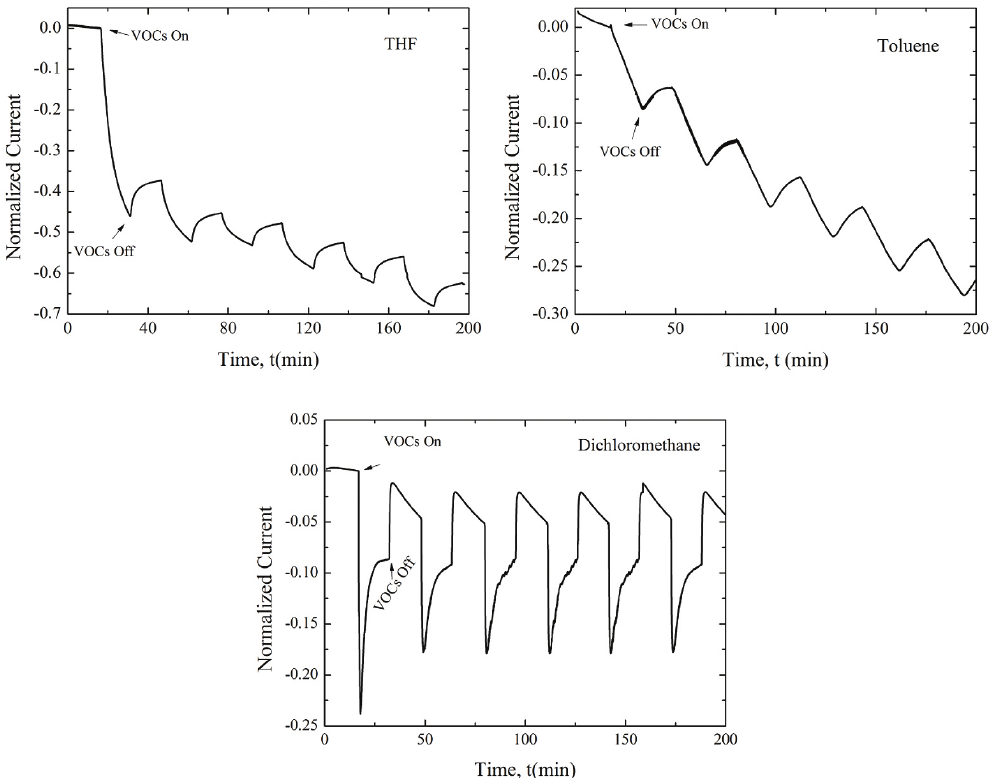
Figure 8. Normalized currents saturation of P3OT/SA (54wt.%) LB films in the presence of